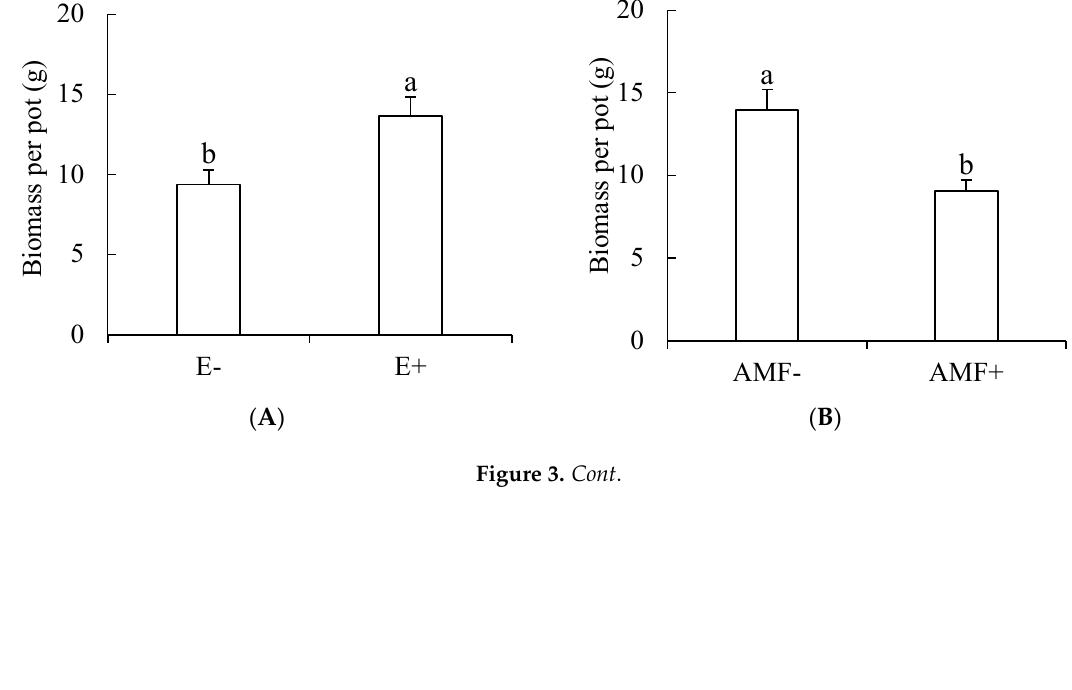
Figure 2. ( A – E ) The influence of endophytic fungi, AMF and rhizobia on the biomass of clover. E+, endophyte-infected tall fescue; E − , endophyte-free tall fescue; AMF+, AMF-inoculated; AMF − , AMF-free; R+, rhizobia-inoculated; R − , rhizobia-free. Different small letters indicate significant differences between treatments ( p < 0.05).